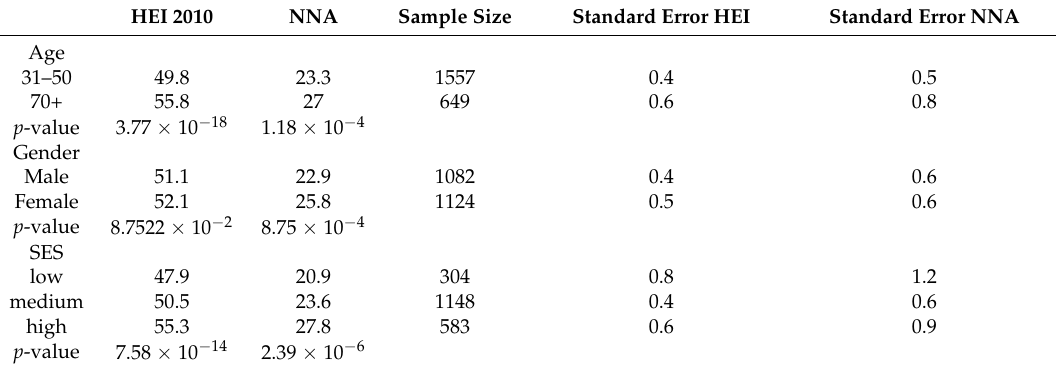
NNA: Nestl é Nutrition Algorithm, HEI: Healthy Eating Index. Table 4. Comparison between NNA and NHANES 2011–2012 (day 1) for age, gender, and socioeconomic status (SES), with no restriction on energy intakes.